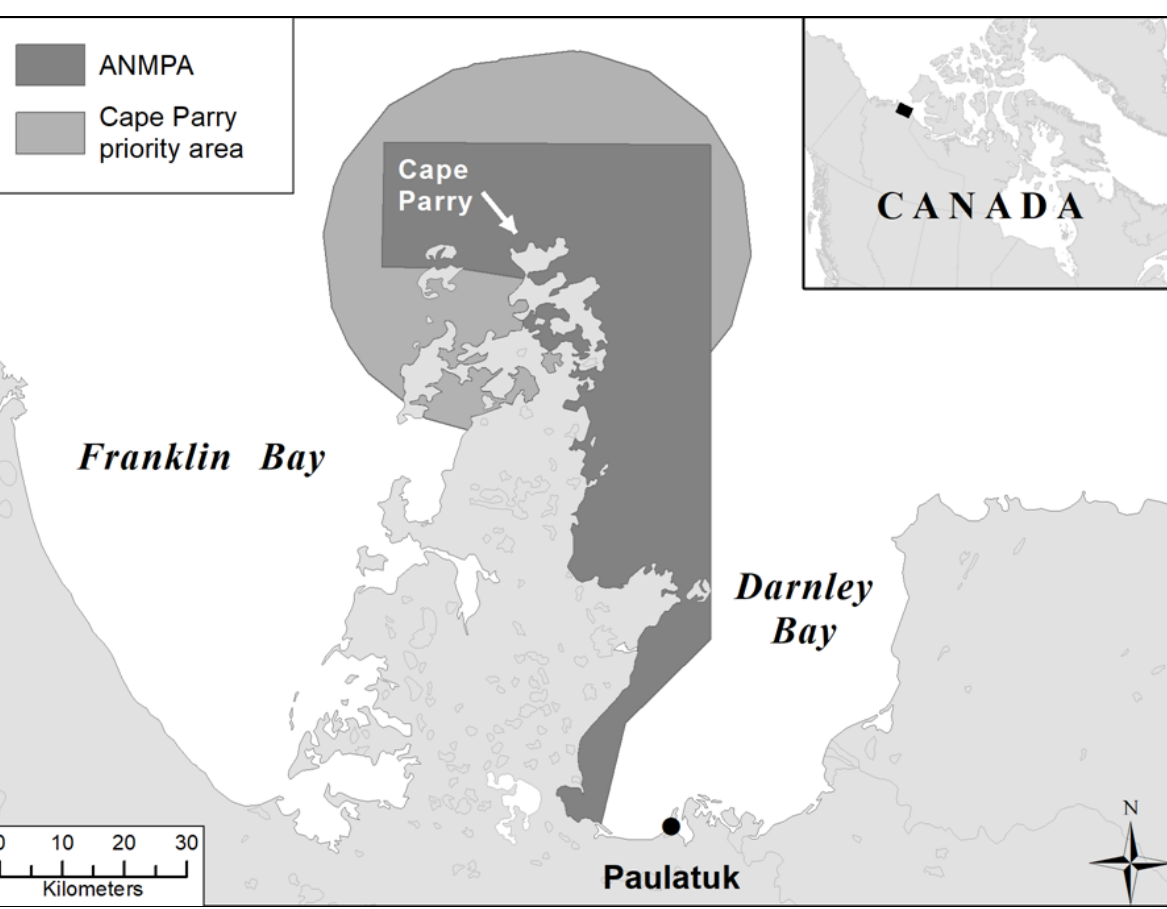
Figure 2. Map of the Cape Parry priority area reviewed during previous science advisory processes on monitoring indicators, protocols, and strategies (DFO 2015), relative to the final boundaries of the ANMPA. Map created by M.